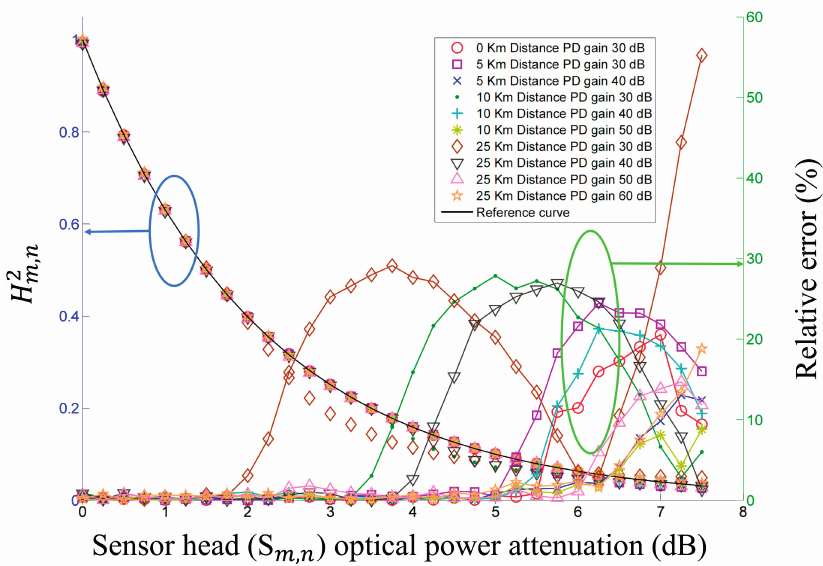
Figure 3. Measured (cid:1834) (cid:3040),(cid:3041)(cid:2870) (left) and relative error (right) versus sensor head optical power attenuation with various remote sensing point distances and PD